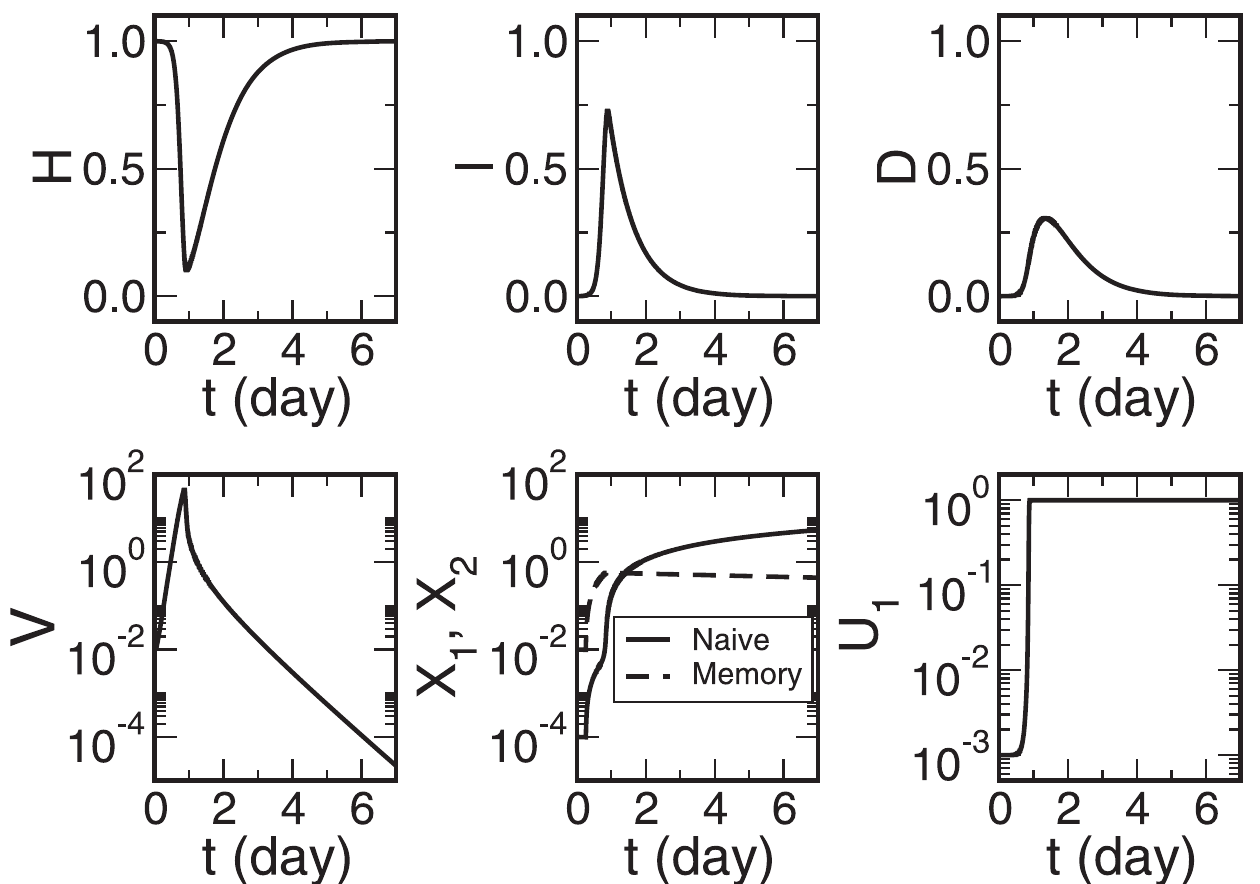
Figure 1. Time courses of the healthy cell concentration H ð Þ , the infected cell concentration I ð Þ , the dead cell concentration D ð Þ , the viral load V ð Þ , the concentrations of naı¨ve and memory antibodies X 1 and X 2 ð Þ , respectively, and the naı¨ve antibody affinity U 1 ð Þ . The memory antibody affinity is U 2 ~ 10 { 3 . The initial conditions are H 0 ð Þ ~ 1 , I 0 ð Þ ~ D 0 ð Þ ~ 0 , V 0 ð Þ ~ 0 : 01 , X 1 0 ð Þ ~ 10 { 4 , X 2 0 ð Þ ~ 10 { 2 , and U 1 0 ð Þ ~ 10 { 3 .